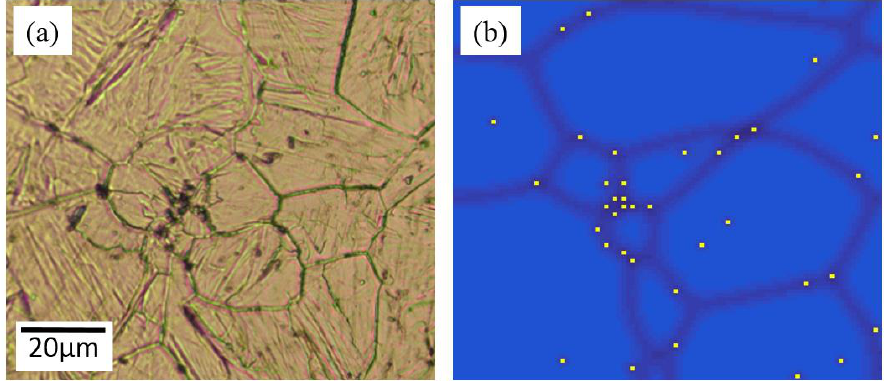
Figure 5. Comparison between experimental and simulation results for 𝜑 = 2: ( a ) in-situ observation, and ( b ) simulation results.